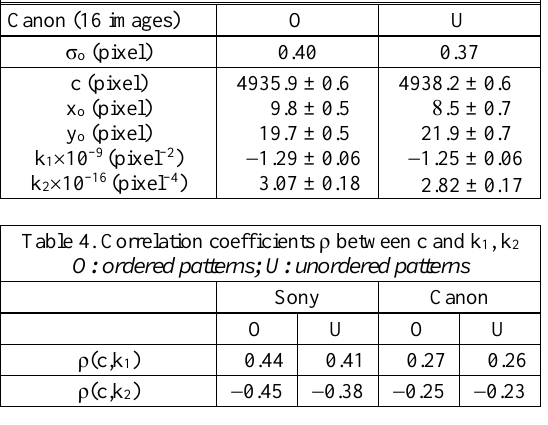
Table 3. Calibration results for Canon camera (16 images) O: ordered patterns; U: unordered patterns